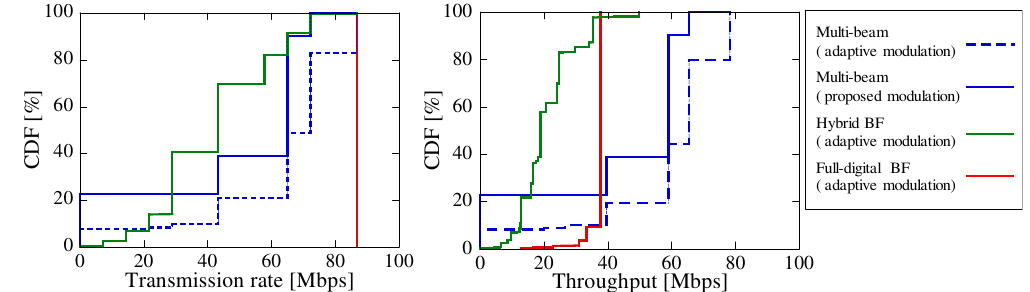
Figure 7. Characteristics of transmission rate and throughput under IEEE802.11ac.